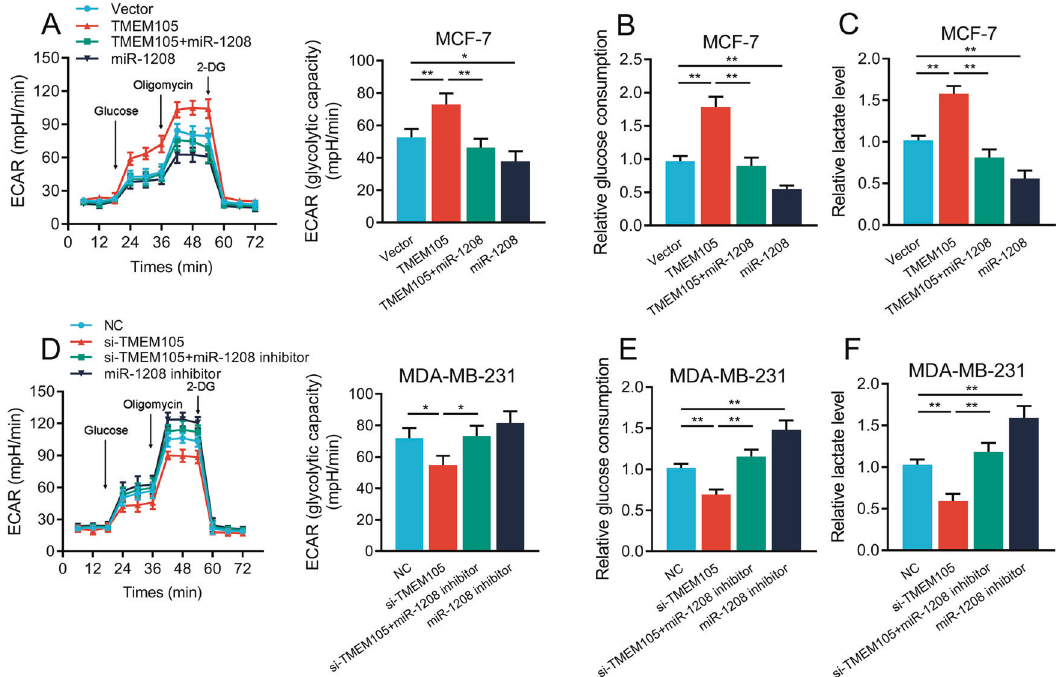
Fig. 6 TMEM105 sponges miR-1208 to facilitate breast cancer cell glycolysis. ECAR level ( A ), glucose consumption ( B ), and lactate production ( C ) were determined in TMEM105-overexpressing MCF-7 cells transfected with miR-1208 mimics. ECAR level ( D ), glucose consumption ( E ), and lactate production ( F ) were determined in TMEM105-knockdown MDA-MB-231 cells transfected with miR-1208 inhibitors. 2-DG 2-deoxyglucose. * p < 0.05, ** p <